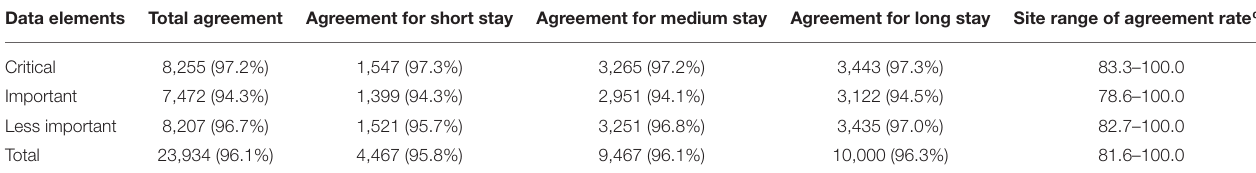
TABLE 1 | Overall agreement rate for all selected audit